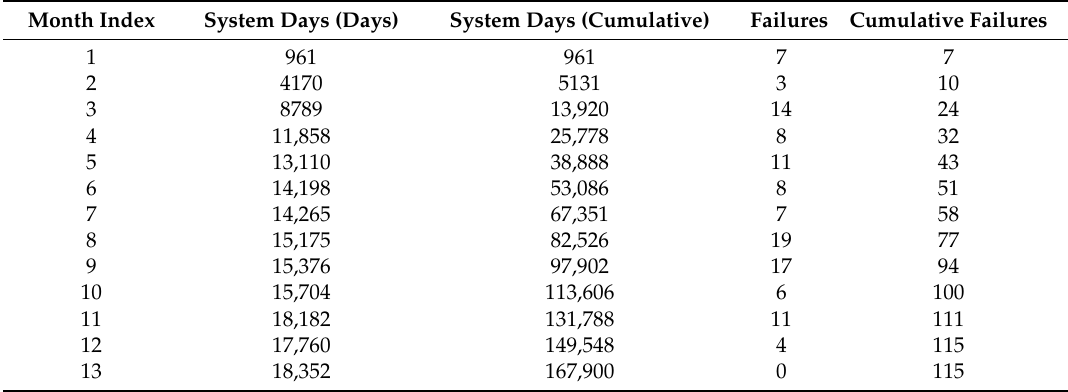
Table 2. Field failure data for Release 1—Dataset